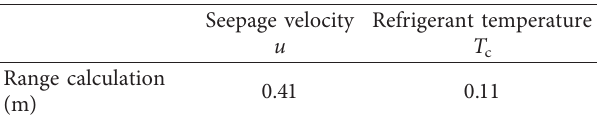
Figure 6: Influences of various factors on downstream length. (a) Seepage velocity u vs. downstream length E T c vs. downstream length E d Table 2: Calculation of range of E d lim .